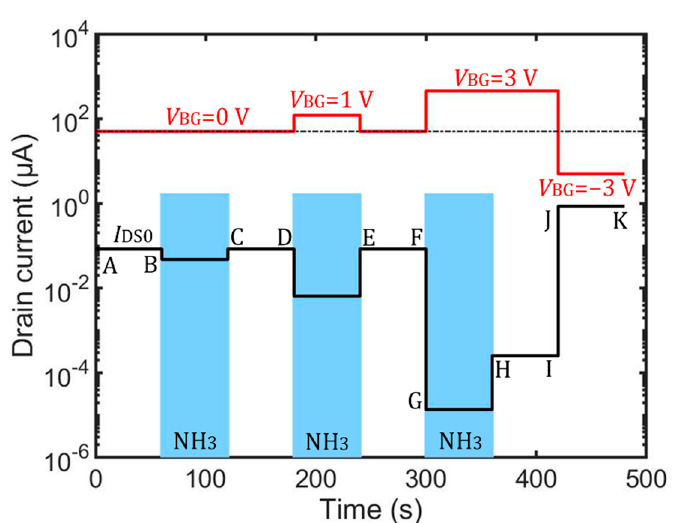
Figure 5. The drain current ( I DS ) response of an accumulation-mode polymer p -type transistor for detecting electron-donating gases under different back-gate voltages, simulated by the ATLAS software. The simulated profile was qualitatively consistent with the experimental result, as shown in Figure 4. The blue rectangles indicate the gas-on states and the red line notes the values and polarities of the back-gate voltages.